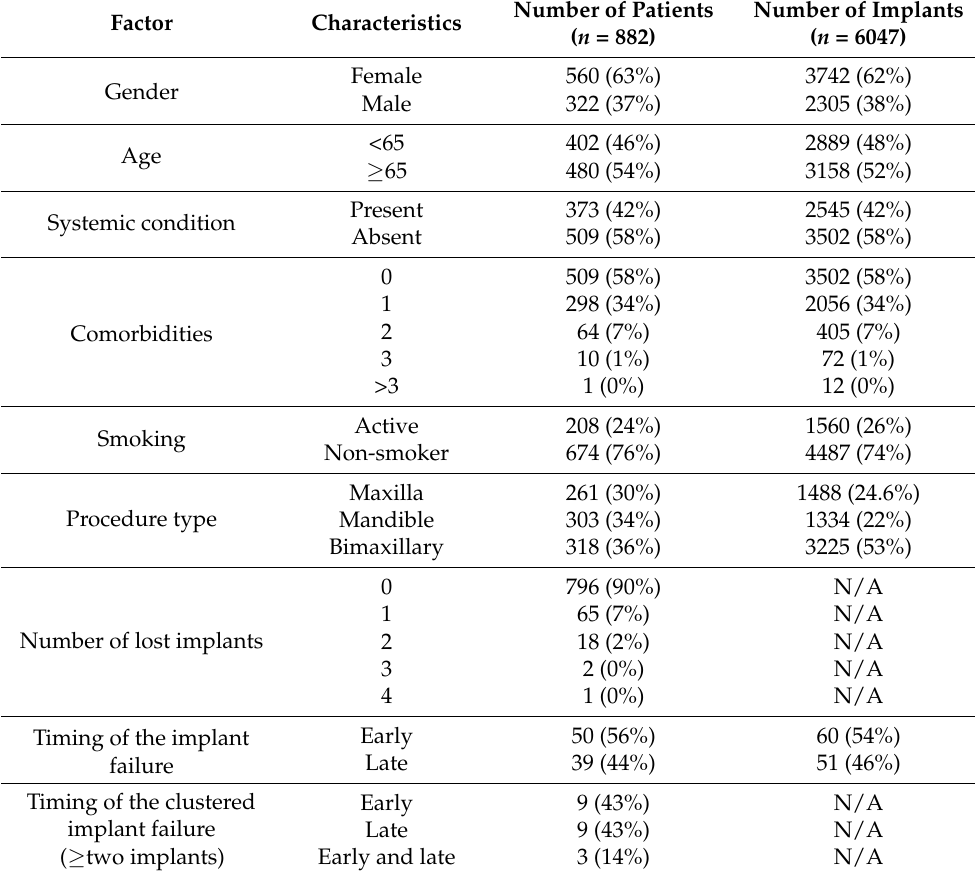
Table 2. Descriptive patient and cohort-related characteristics. Abbreviations: SD, standard devi- ation; IQR, interquartile range; N/A, not applicable, i.e., calculation not suitable at the patient or implant